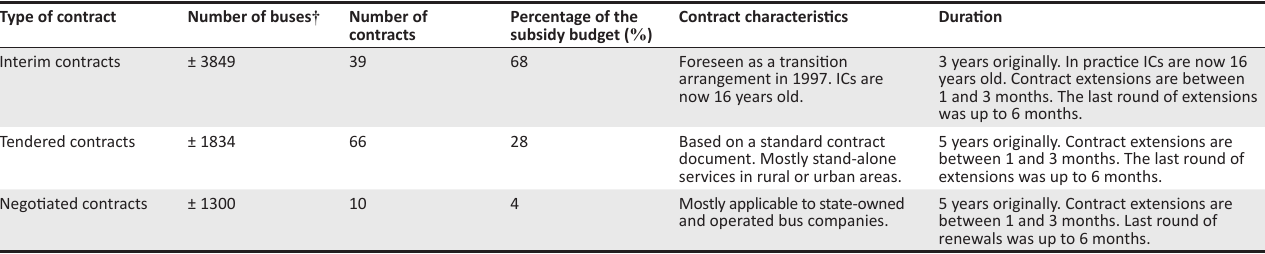
TABLE 1: Current status of tendering and contracting in South Africa. Type of